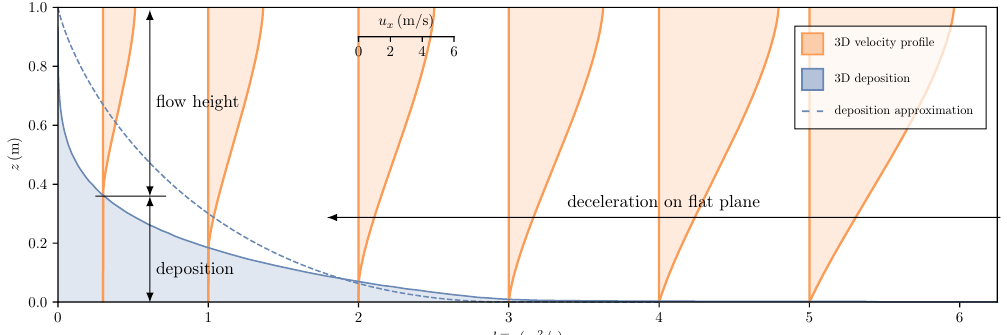
Figure 2. The deposition depth as a function of the depth-integrated momentum from granular simulations (not depth-averaged). The respective velocity profiles during deceleration on a flat plane for each given momentum h ¯ u x are shown in orange. The dashed line shows the behaviour of the relation for the depth-integrated model derived in Equation